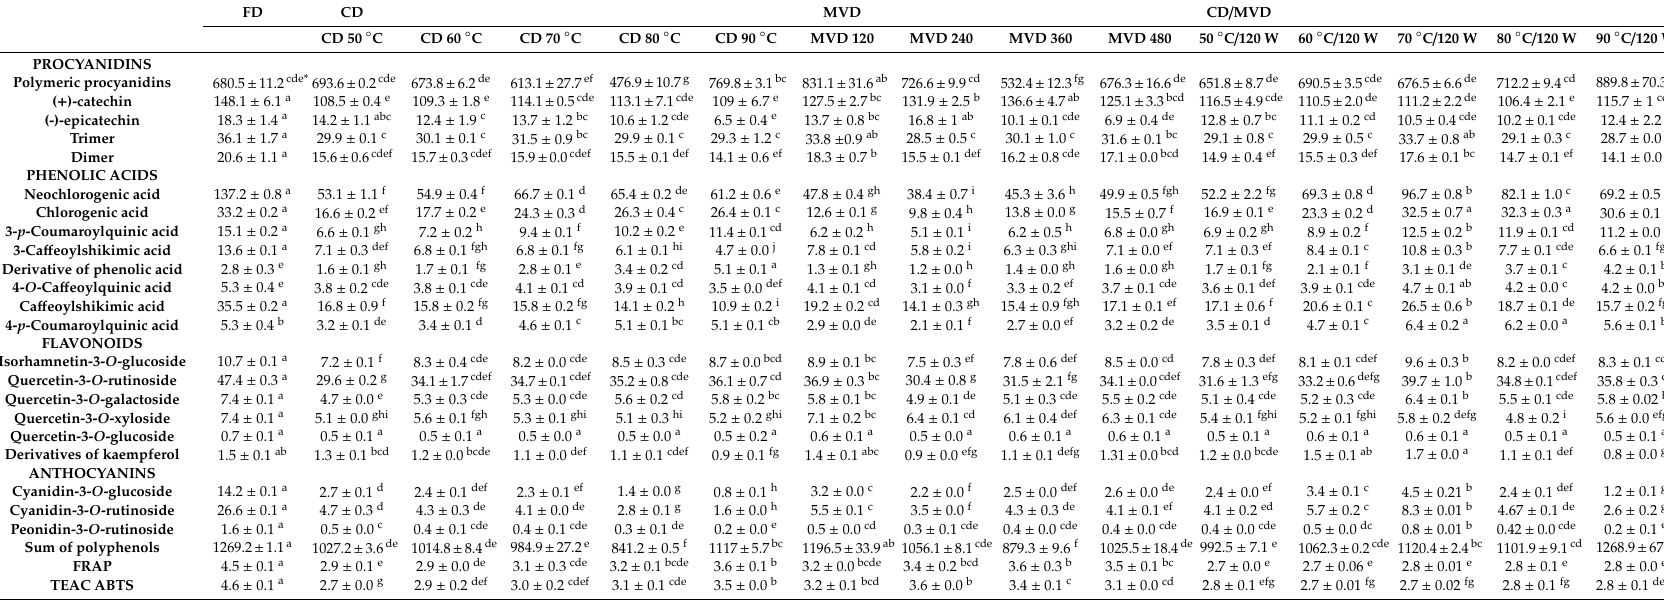
Table 3. Polyphenolic compounds (mg · 100 g − 1 dm) and antioxidant capacity (mmol Trolox · 100 g − 1 dm) of plum pomace powders obtained using selected drying methods ( n =